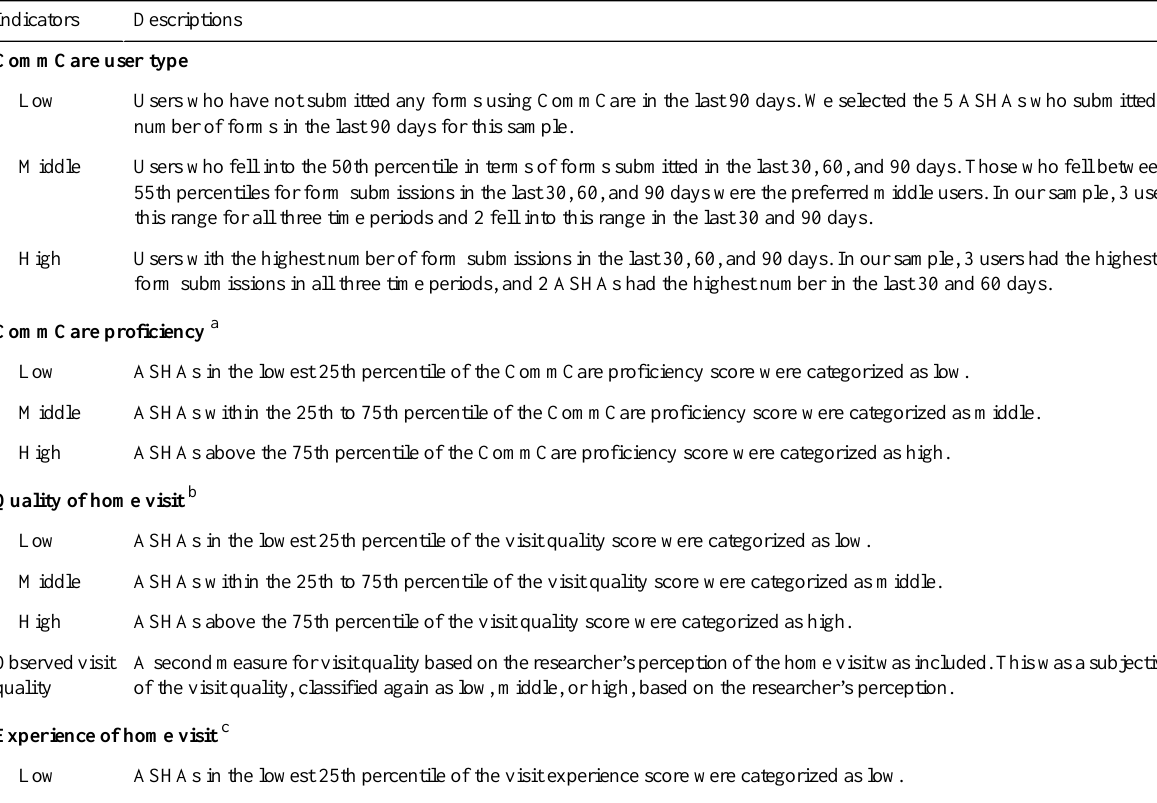
Table 2. List of indicators and their